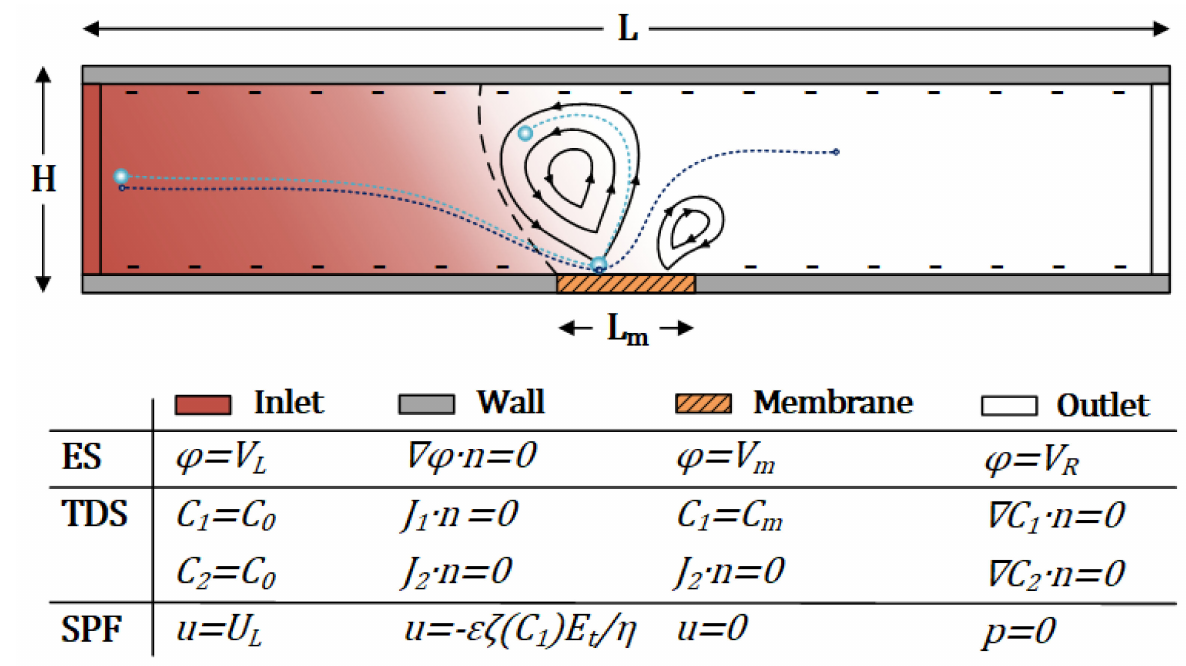
Figure 1. Schematic illustration of the numerical model and the boundary conditions associated with each set of physics. The nano-junctions are modeled as a constant concentration and voltage boundary condition. Larger particles (cyan) are trapped due to larger net forces, while smaller ones (blue)